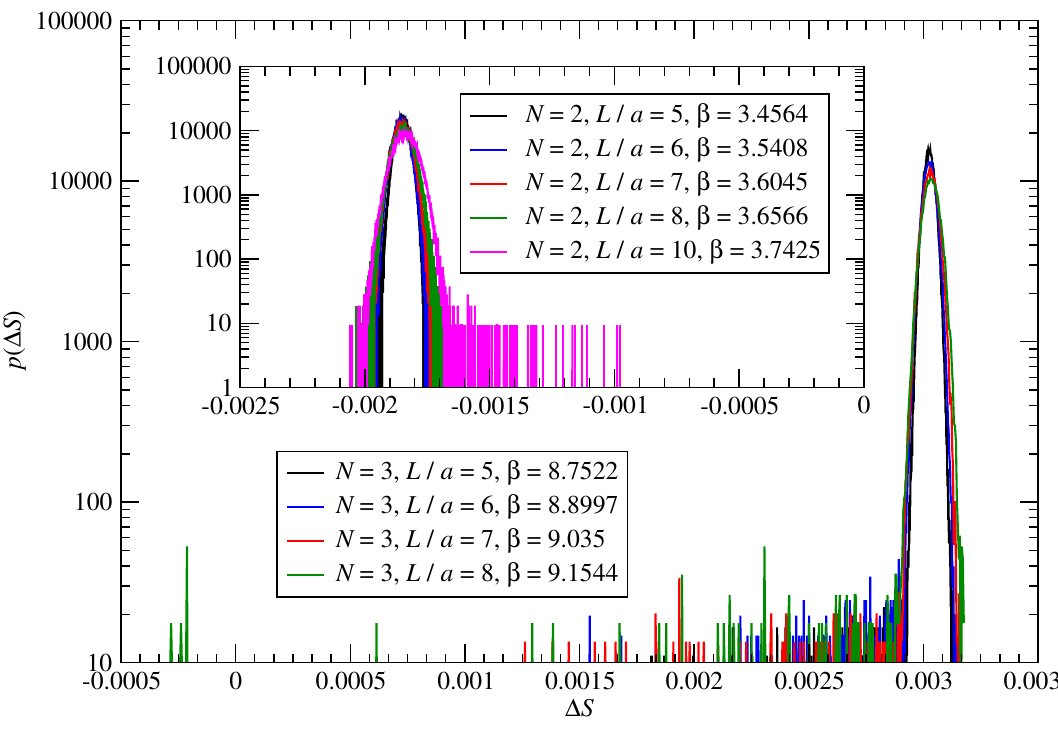
Figure 9 . The main plot shows a comparison of distributions for the Euclidean action di(cid:11)erence (cid:1) S obtained in \direct" non-equilibrium trajectories in SU(3) Yang-Mills theory, from a set of simulations on lattices with approximately constant g 2 ( L ) (i.e. approximately (cid:12)xed physical size L ), for di(cid:11)erent values of L=a , as listed in the (cid:12)rst block of table 9. The inset shows an